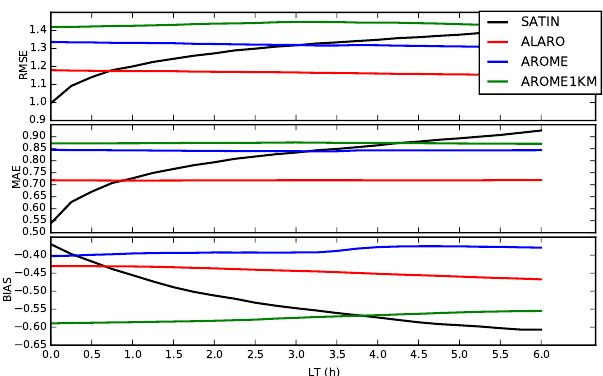
Figure 7. Comparison of pure (translational) nowcasting with NWP models: relative RMSE, MAE and Bias versus lead time, averaged over five days with heavy